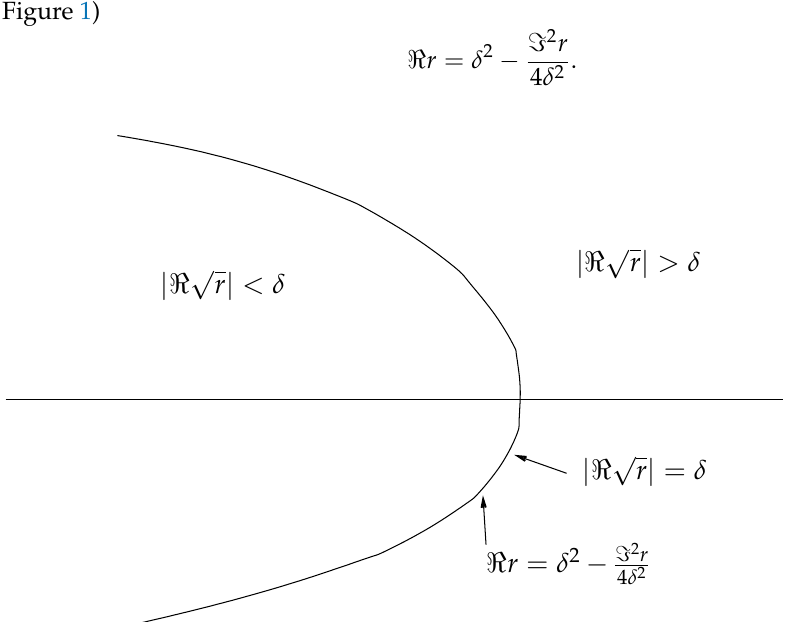
Figure 1. Splitting of the complex plane into two parts by the horizontal parabola (cid:60) r = δ 2 − (cid:61) 2 r